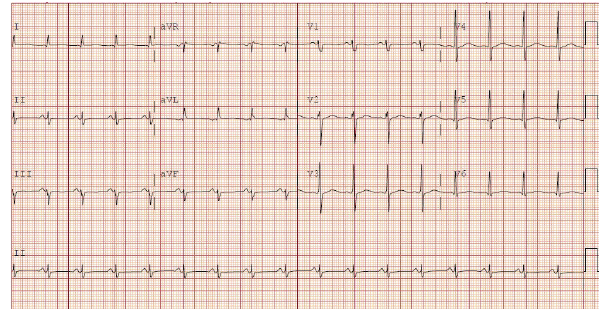
Figure 2: ECG showing sinus tachycardia without ST-segment or T-wave abnormalities.